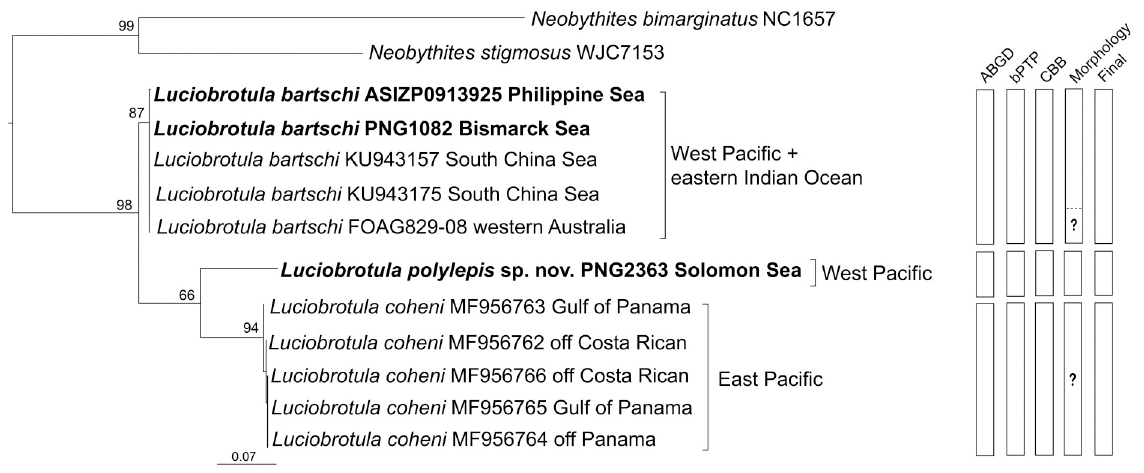
Fig. 2. Phylogenetic tree of species of Luciobrotula Smith & Radcliffe 1913 inferred by the partitioned maximum-likelihood method with GTR+G nucleotide substitution model based on the COI gene dataset, and results from species delimitation based on COI gene analyses with ABGD, bPTP and CBB. Branch lengths are proportional to inferred nucleotide substitutions. Numbers at nodes represent bootstrap values in percentages. Values < 50% are not shown. Taxa names in bold indicate newly obtained sequences in this